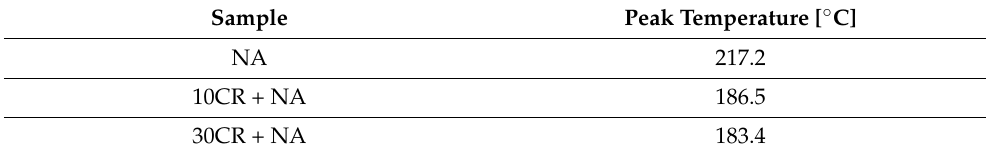
Table 1. Peak temperature of cluster dissolution of NA, 10CR+NA and 30CR+NA samples. Sample